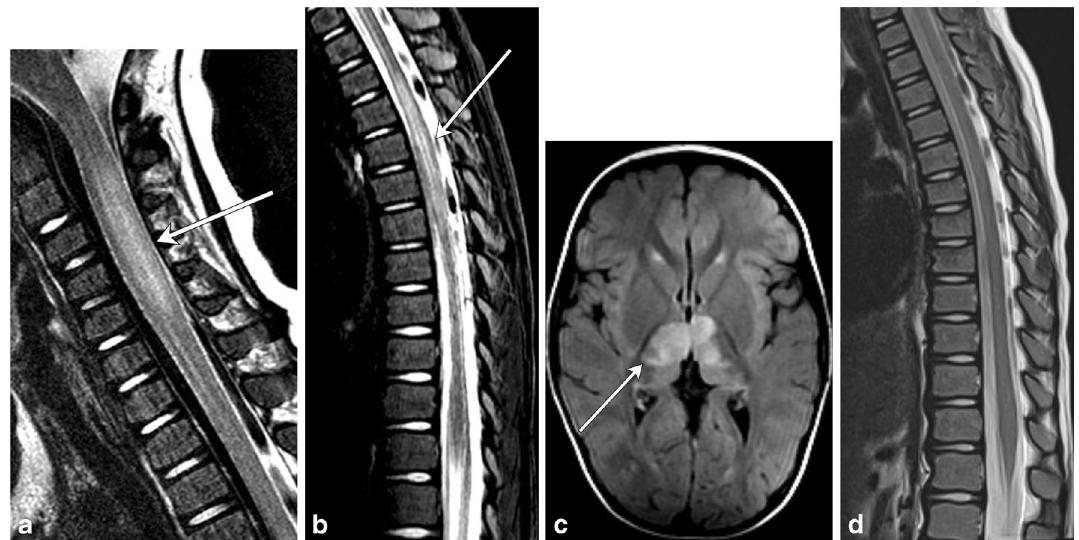
Fig. 7 Acute disseminated encephalomyelitis (ADEM). A 2-year- old boy with recent upper respiratory tract infection and low- grade fevers presents with lower extremity weakness and diffi- culty walking. a and b Sagittal T2 images of the cervical and thoracic spine demonstrate long-segment areas of hyperintensity